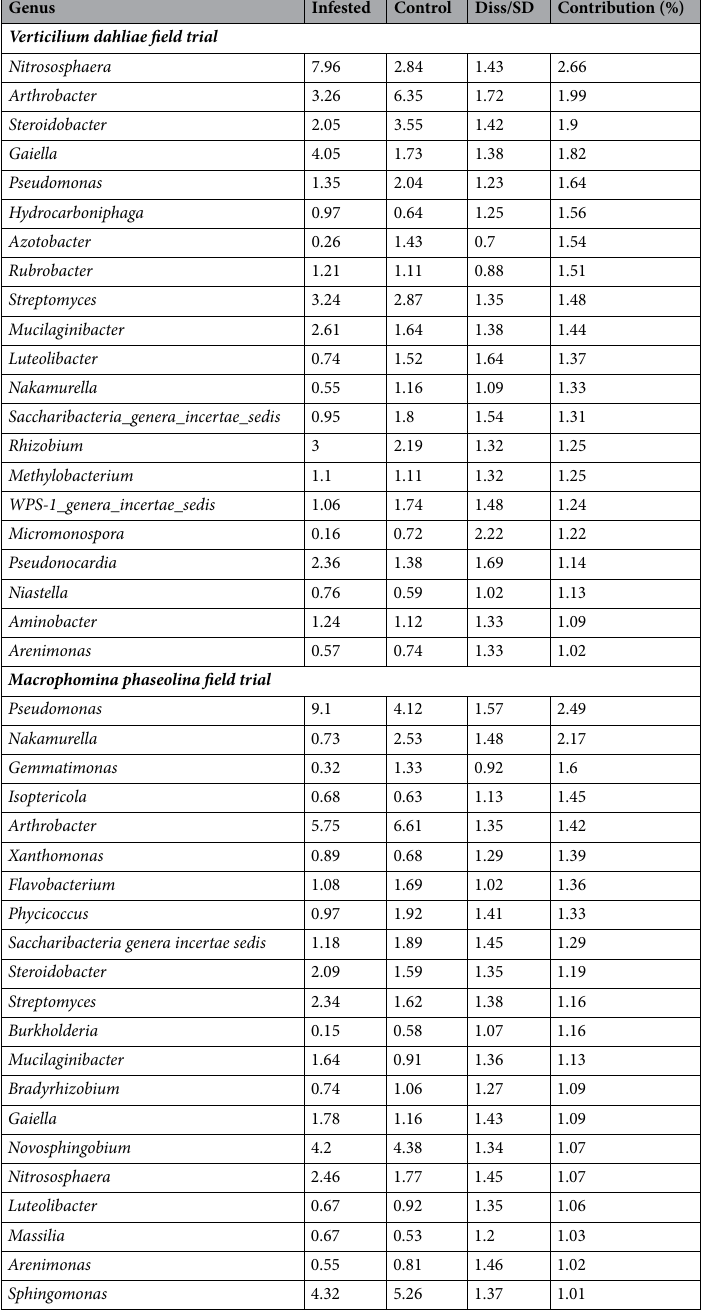
Table 1. Average percent relative abundances of bacterial genera contributing to at least 1% to the observed variability between the rhizosphere of infested vs. control plants via SIMPER analysis. Diss/SD values represent the average dissimilarity divided by the standard